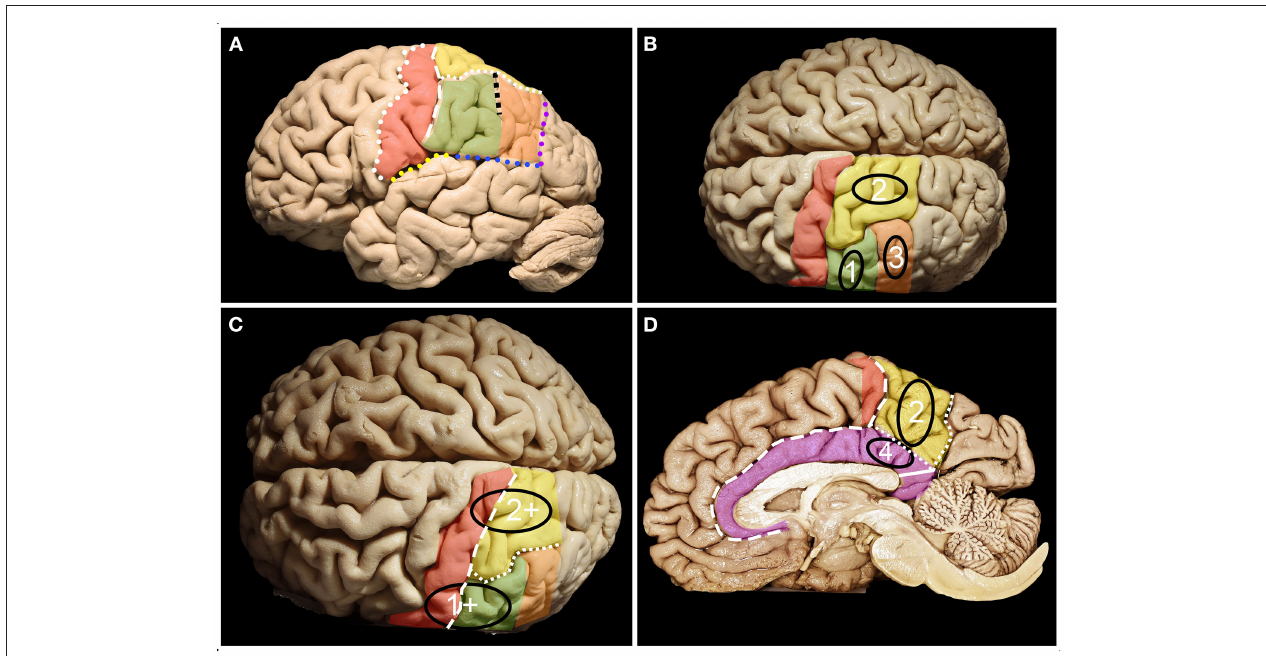
FIGURE 1 | Anatomy of the parietal lobe from lateral, mesial and superior perspectives. (A) The parietal lobe is placed posteriorly to the central sulcus (white dots), which is one of the most constant landmarks on the convexity of the brain. The posterior border and inferior border of the parietal lobe on the lateral surface are marked by the temporoparietal line (purple dots) and parieto-occipital line (blue dots) with the posterior ramus of the lateral sulcus (yellow dots), respectively. Running parallel to the central sulcus, the postcentral gyrus (red) can be identified, which is limited posteriorly by the posterior central sulcus (white rectangles). Posterior to the postcentral sulcus, superior (yellow) (SPL) and inferior (green + orange) parietal (IPL) lobules are identified, which are separated by the intraparietal sulcus (white squares) (IPS). The IPS and postcentral sulcus junction patterns can be defined according to the Cunningham into one of the five subtypes: I. postcentral sulcus is divided into superior and inferior portion, IPS separate; II. inferior post-central confluent with IPS, superior postcentral separate; III. superior and inferior post-central confluent, IPS separate; IV. superior and inferior postcentral confluent and unified with IPS; V. IPS confluent with the superior post-central and inferior post-central separate (4). The superior branch of the IPS (the sulcus of Brissaud) is localized within the SPL. The inferior branch of the IPS (black squares) (the sulcus of Jensen) separates the SMG (green) anteriorly from the AG (orange) posteriorly. (B) Parietal lobe glioma classification according to Berger et al. distinct three zones 1, 2 and 3 on the lateral brain surface that correspond to SMG, SPL and AG retrospectively. (C) Tumors in zones 1 and 2 extending anteriorly beyond the SMG and SPL become tumors within zones 1 + and 2 + . (D) Zone 2 consists of the mesial surface of the precuneus, while Zone 4 consists of the gyrus cinguli below the precuneus. On the medial surface of the hemisphere. The parietal lobe is defined by the precuneus (yellow) and the posterior part of the paracentral lobule (red). The anterior border of the precuneus is marked by the marginal branch of the cingulate sulcus (white rectangles), posterior by the parieto-occipital sulcus (white squares) and inferior by the subparietal sulcus (white dots). Below which the cingulum (purple) covering the corpus callosum is identified. The isthmus of the cingulum (white continuous line) at the level of the posterior surface of the splenium of the corpus callosum was